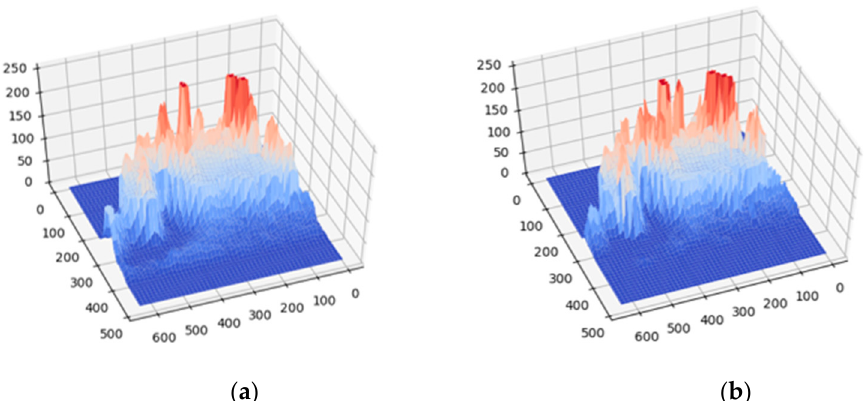
Figure 5. Three-dimensional distribution diagram: ( a ) label calculation distribution; ( b ) unsupervised learning acquisition distribution.